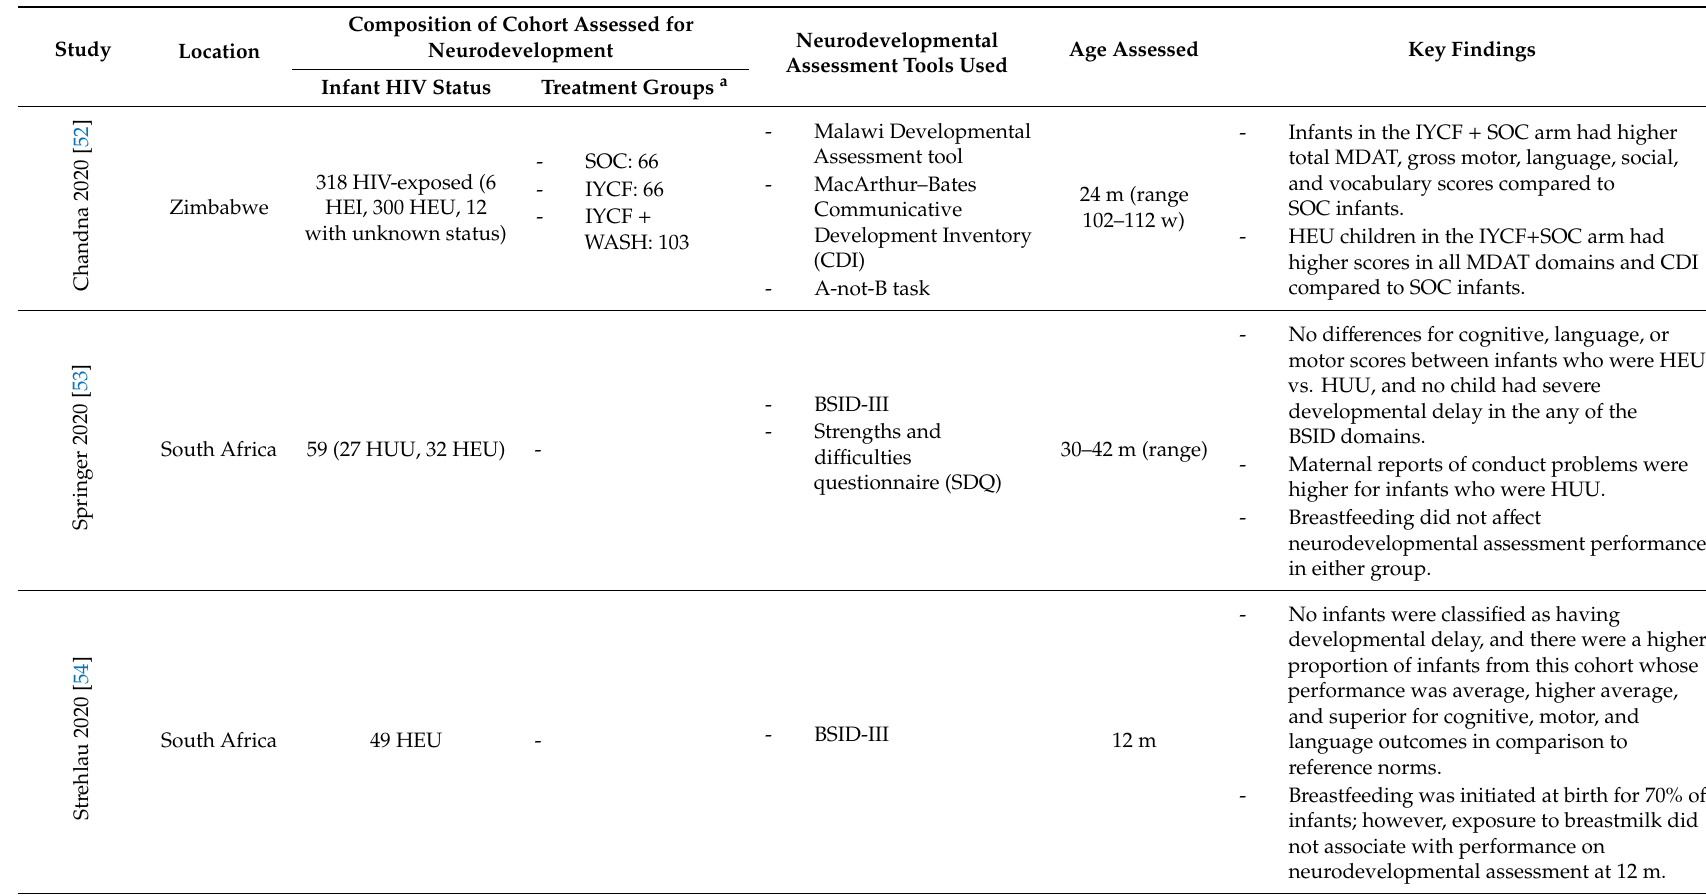
Table 2. Summary of key findings on the influence of nutrition-related factors and interventions on neurodevelopmental outcomes in infants born to mothers living with